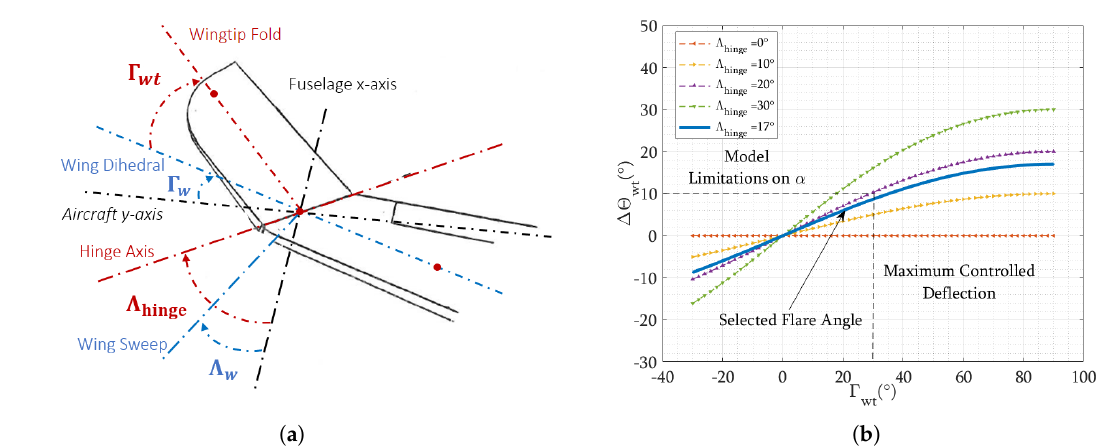
Figure 2. Flared dihedral folding wingtip mechanism: ( a ) sketch of the morphing wingtip geometry; and ( b ) local twist modification ∆ θ wt with Γ wt and Λ hinge